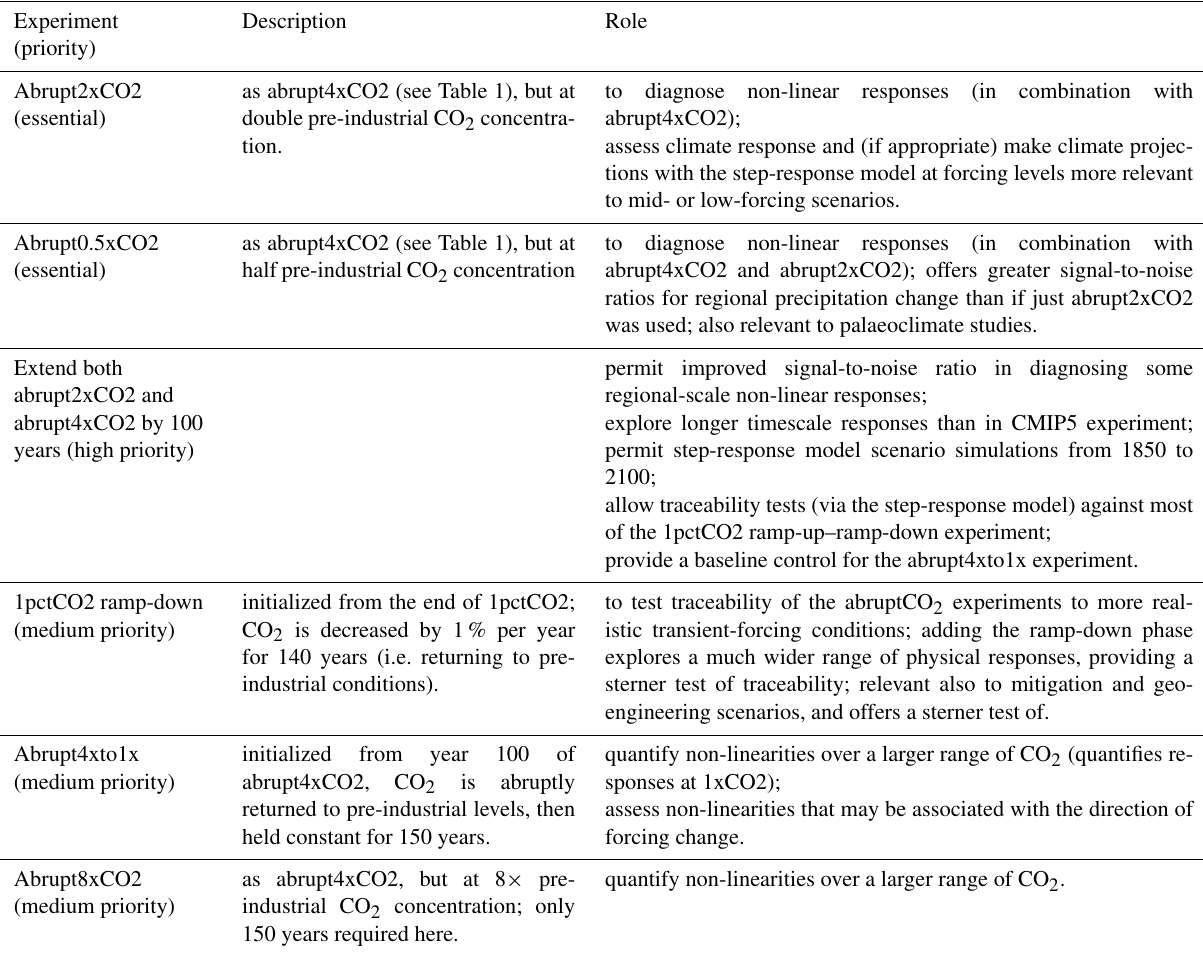
Table 2. nonlinMIP experimental design. Three options are only the “essential” simulation, all “high priority” plus the “essential” simula- tions, or all simulations. The experiments in Table 1 are required in all